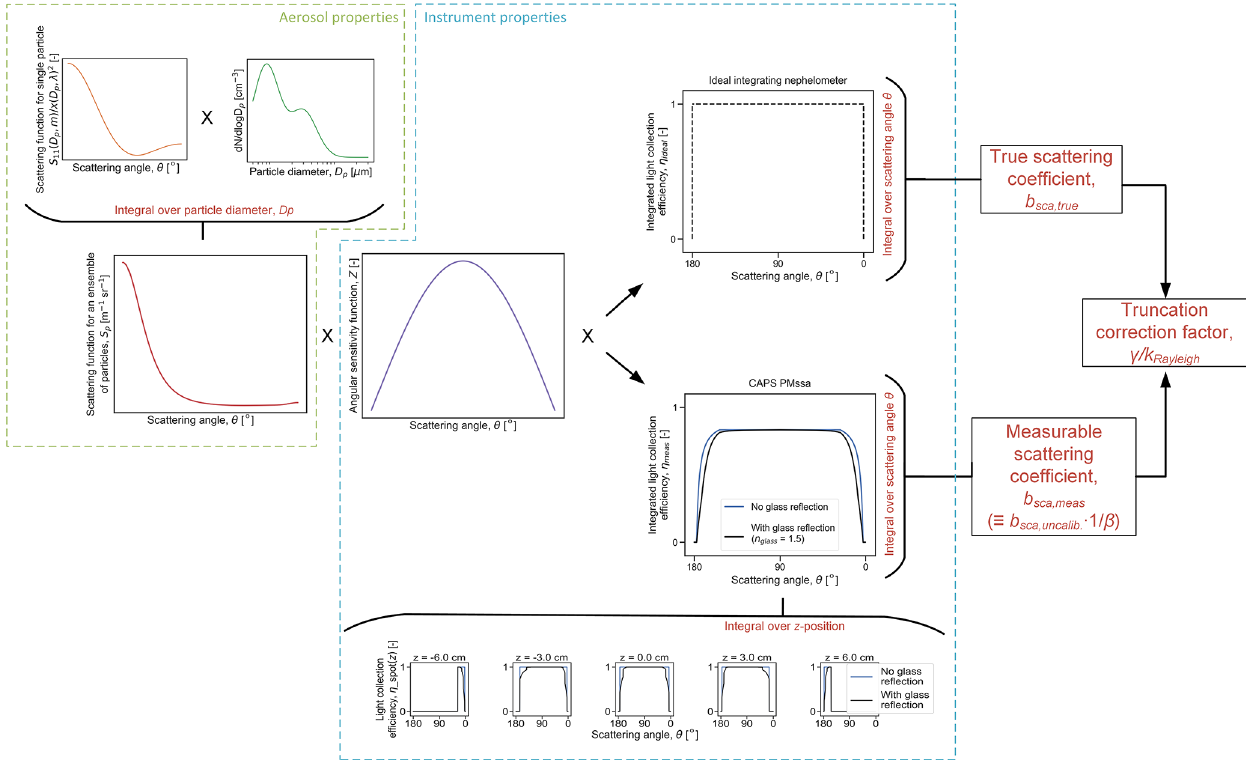
Figure 3. Schematic diagram of the new model for calculating truncation correction factors for the CAPS PMssa. Full details of the calcu- lations are presented in Appendix A. The model requires as input a light collection efficiency function and an angular sensitivity function, which are determined by the geometry of the CAPS PMssa optical system; and a scattered light intensity function for the ensemble of parti- cles being measured, which is a function of the particle size distribution (dN, / dlogDp) and size-dependent aerosol scattering-phase function. The main output of the model is the truncation correction factor, γ